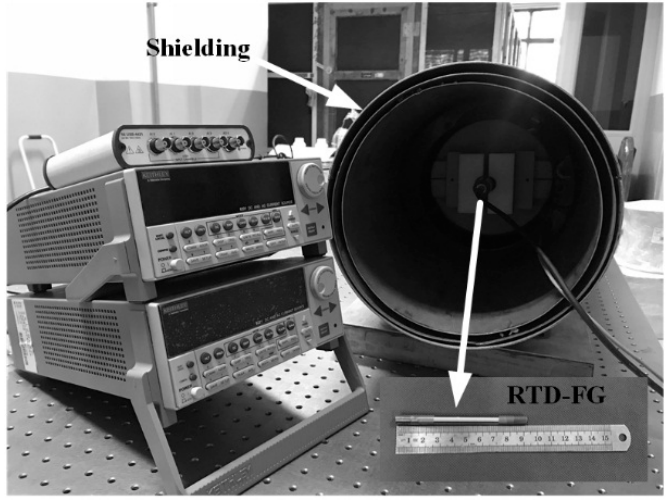
Figure 7. Testing system that includes RTD fluxgate, excitation signal generator, DAQ equipment, coil producing bias field and shield cylinder.